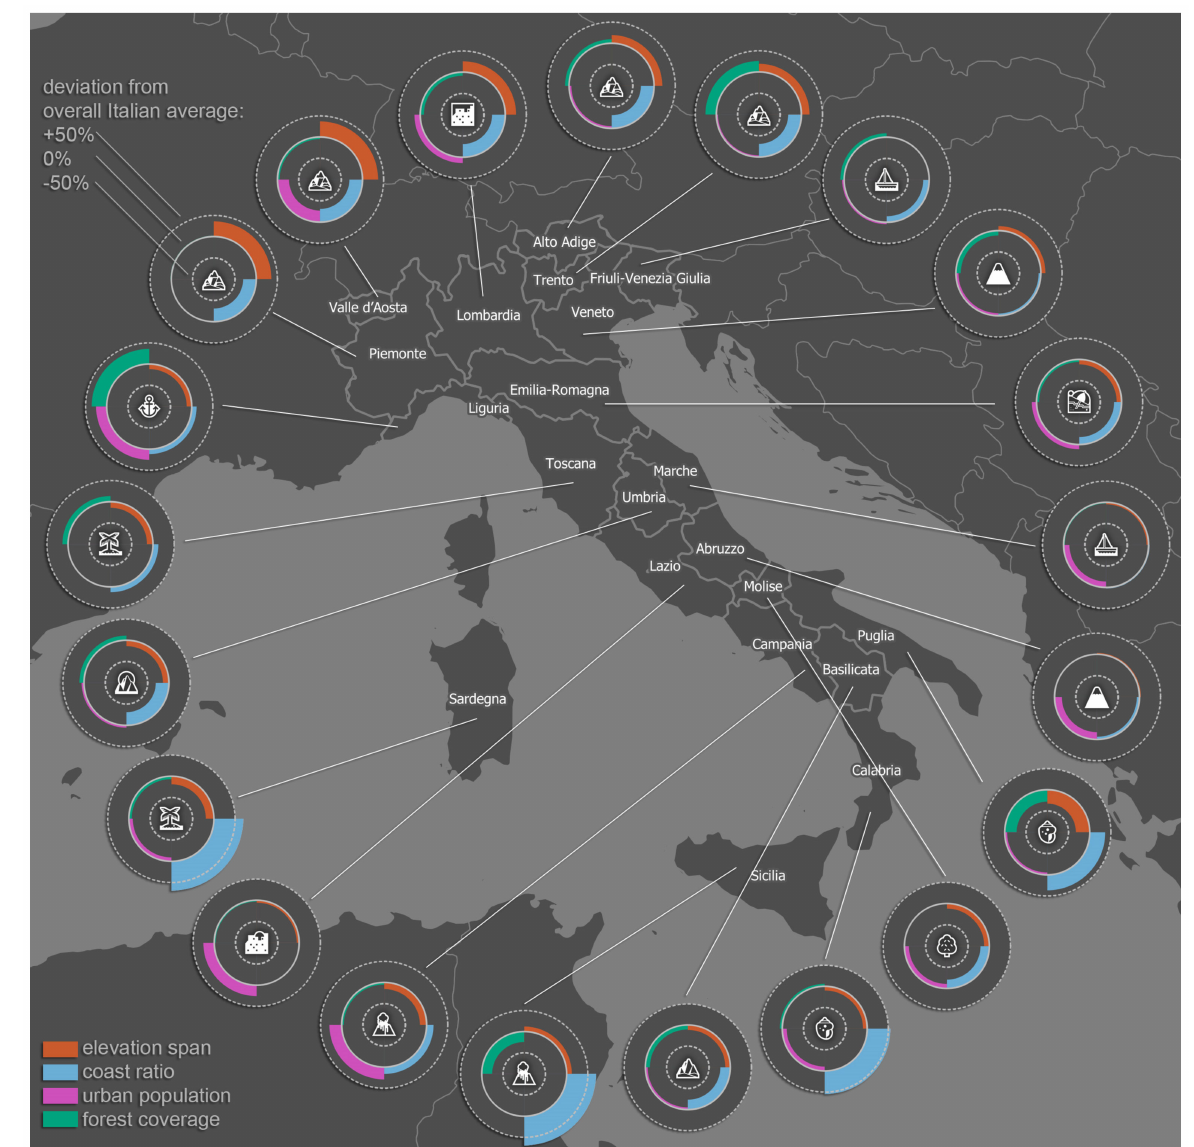
Figure 13. Map of typical location-specific emojis and percentage deviation of four geographic attributes from overall Italian average per administrative